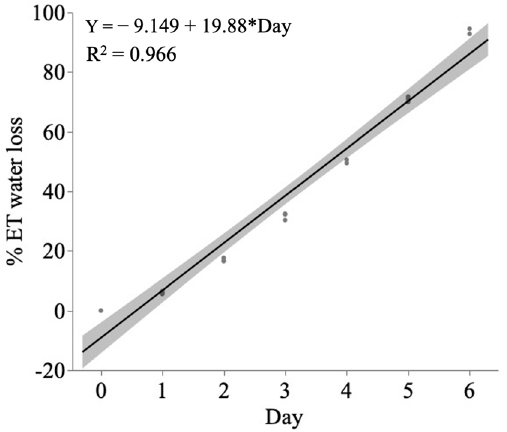
Figure 4. Establishing water infiltration regime for inducing drought stress. Drought induction water regime was determined by assessing the relationship between evapotranspiration rate against day in maize hybrids using linear regression analysis. Days taken to reach 50% ET water loss was determined by the equation of the line (Y = − 9.149 +15.88 × Day) and calculated to be ≅ 4 days (=3.7 days). Additionally, watering at 2-day intervals would keep ET water loss within the desired ranges 0–30% (=23% ET water loss). The shaded region shows the 95% confidence of the fitted line, which is the daily ET water loss for the mean of three hybrids (Midwest × South 1, Midwest × South 2, and South × South). There was no significant difference in the mean lines for each hybrid (not shown, n = 21, F 2,2 0.014, p =